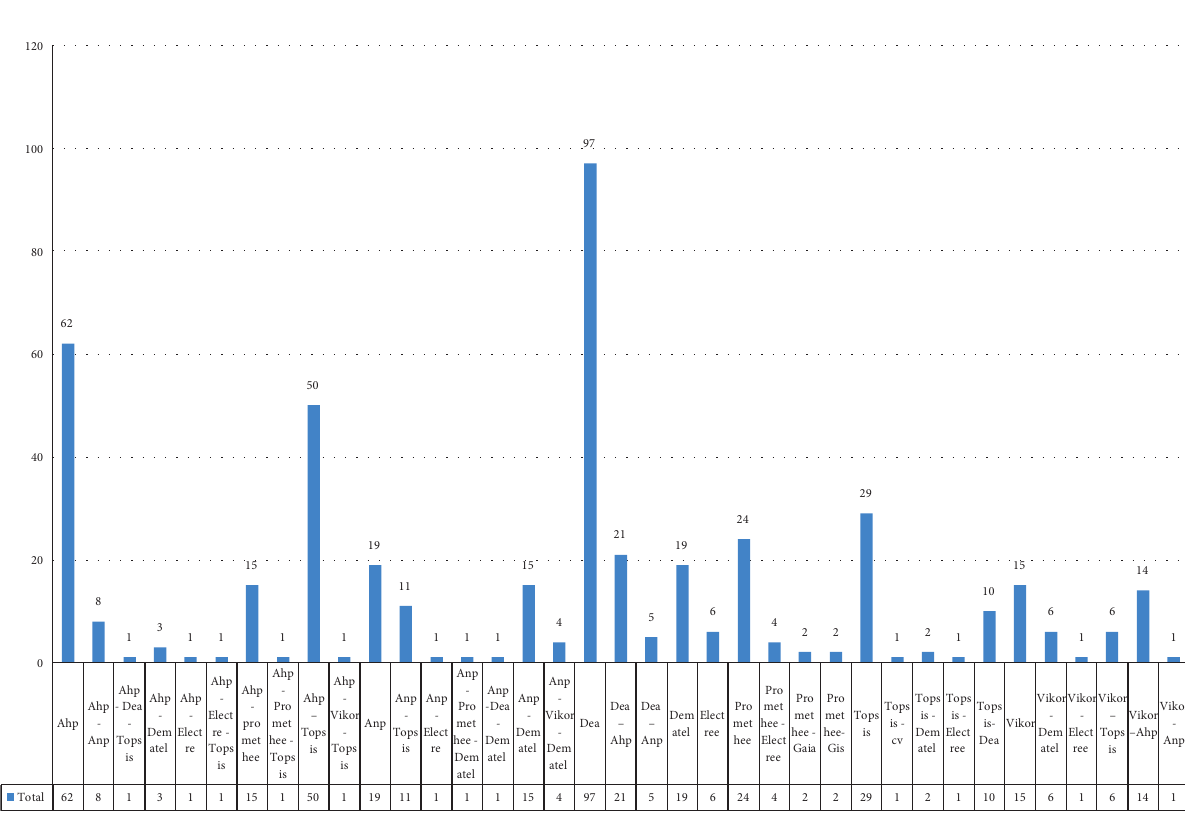
Figure 2: Count of